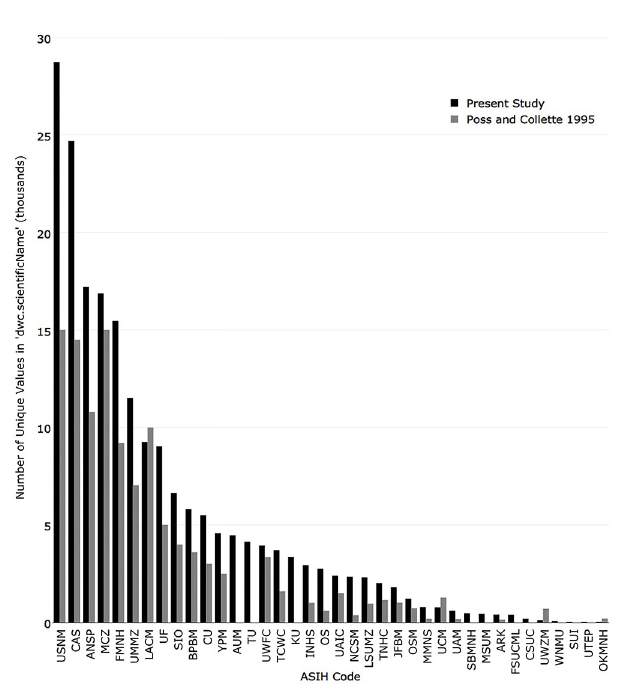
Fig 10. Comparison of the number of unique scientific name values currently published in iDigBio (black) with the number reported in Poss and Collette (1995) (grey).